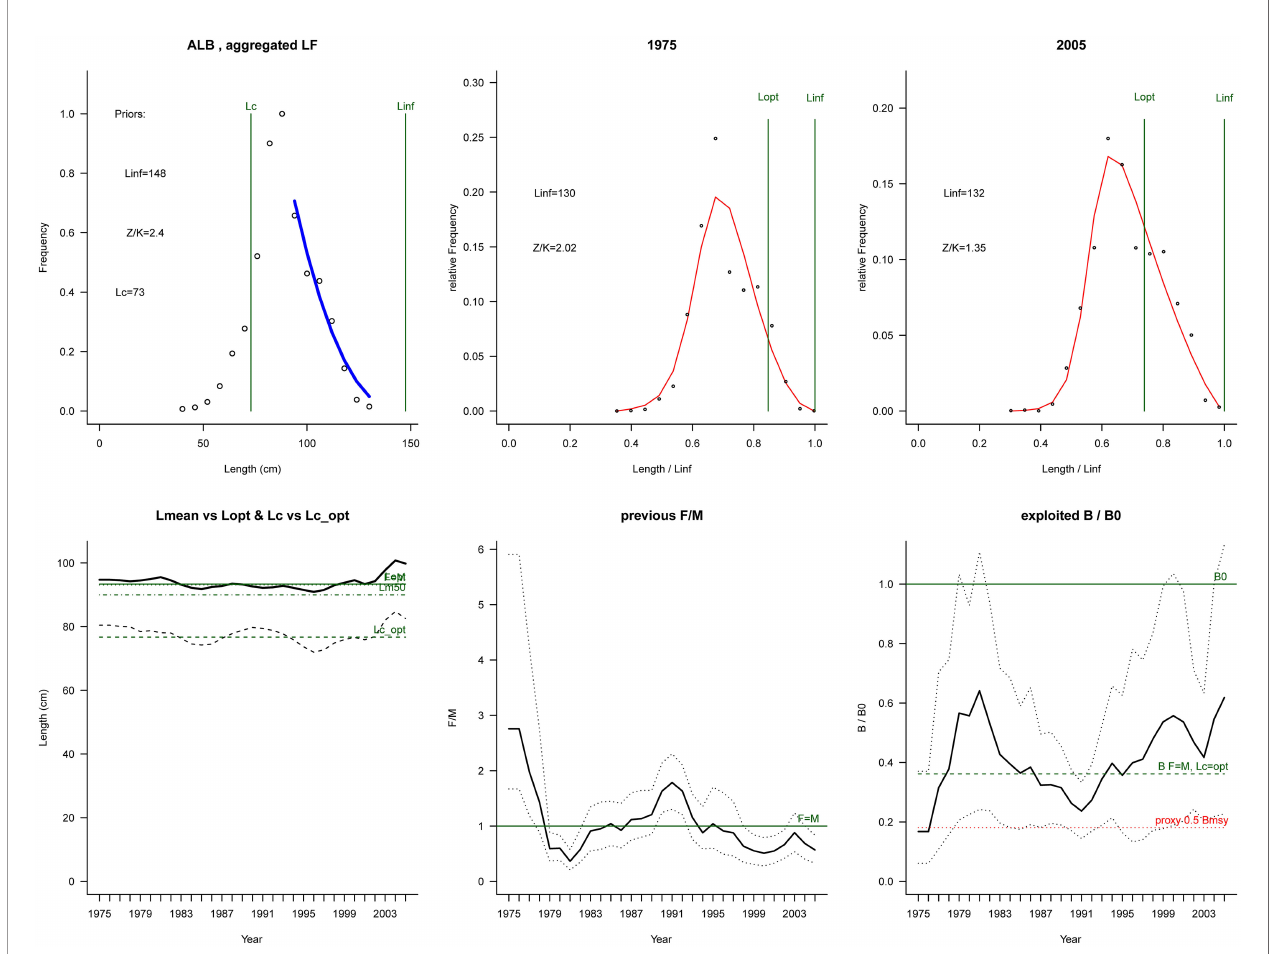
FIGURE 4 | Graphical output of LBB for the southern Atlantic albacore ( Thunnus alalunga ) fi shery (under the condition of setting L inf at 147.5 cm). The top left panel shows the accumulated length-frequency data used to estimate priors for L c , L inf , and Z / K . The top middle and right panels show the length-frequency data for the fi rst and last years in the time series. The bottom left panel shows L mean (bold black curve) relative to L opt and L c (dashed black curve) relative to L c_opt . The bottom middle panel shows relative fi shing pressure F / M (black curve), with approximately 95% con fi dence limits (dotted curves). The bottom right panel shows relative biomass B / B 0 (black curve) with approximately 95% con fi dence limits (dotted black curves), with an indication of a proxy for B MSY (green dashed line) and a proxy for 0.5 B MSY (red dotted